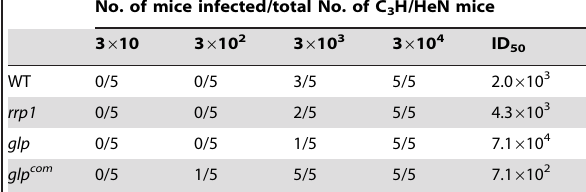
Table 3. ID 50 values of various B. burgdorferi strains. No. of mice infected/total No. of C 3 H/HeN